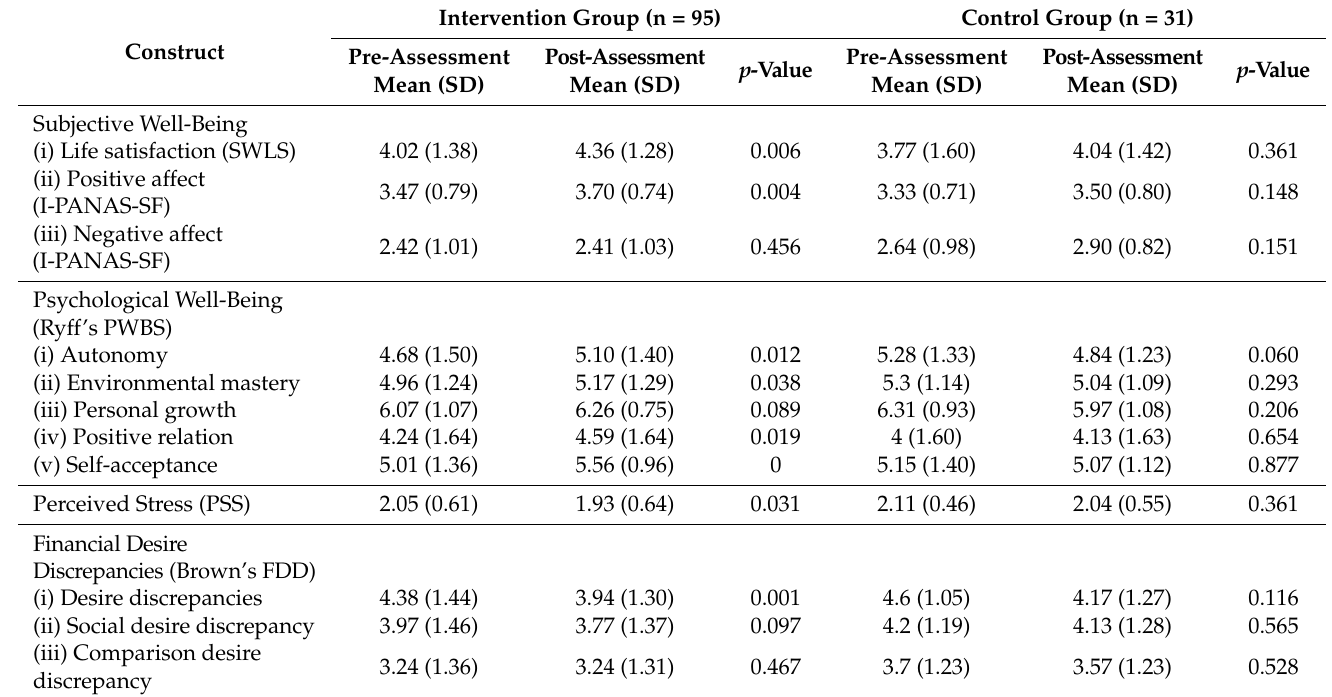
Table 4. Results of Wilcoxon Signed-Rank